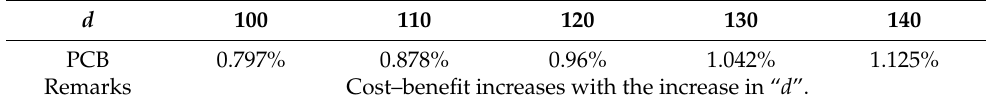
Table 4. Sensitivity of defective rate to cost–benefit. The static input values of the parameters